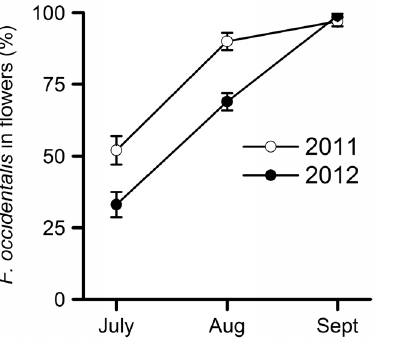
Figure 4. Thrips species composition through the season in strawberry. The percentage of adult thripids in semi-protected strawberry flowers that were Frankliniella occidentalis in 2011 and 2012 ( n . 100 for all samples). The error bars are the standard error of the proportion from the sample.